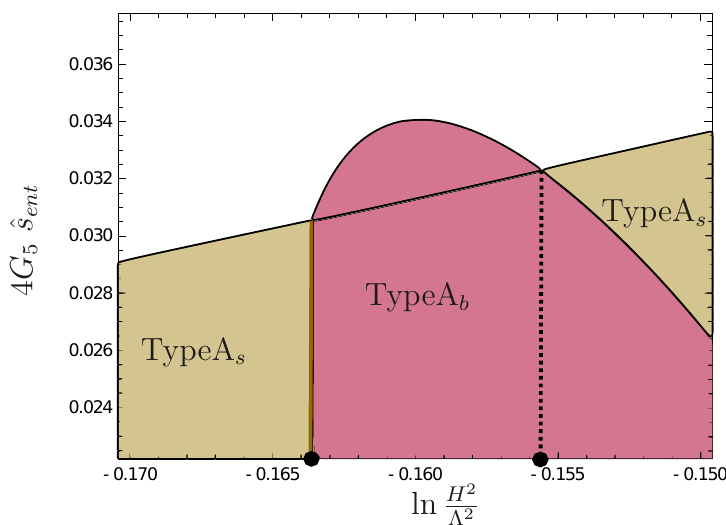
Figure 3 . From [17]. Vacuum entanglement entropy densities of the chirally symmetric DFP (TypeA ), and the DFP with spontaneously broken chiral symmetry (TypeA s of ln H 2 Λ 2